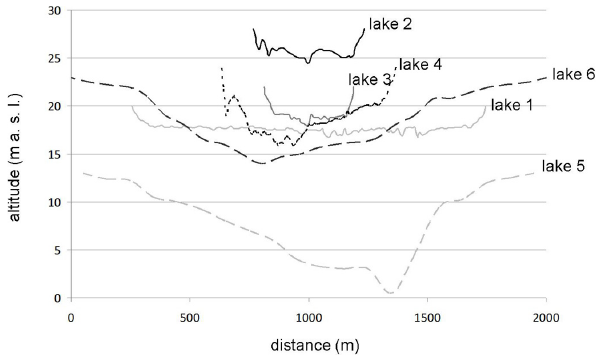
Fig. 8. Bathymetric profiles of lakes in relation to relief posi- tion. For lake locations see Fig. 4. Lake areas and profile di- rections are as follows: lake 1=1841400m 2 , from N to SE; lake 2=104400m 2 , from N to S; lake 3=221400m 2 , from N to S; lake 4=421200m 2 , from N to S; lake 5=1636790m 2 , from NW to SE; lake 6=2460134m 2 , from N to S. Bathymetric data from lakes 5 and 6 from Pavlova and Dorozhkina (2000).